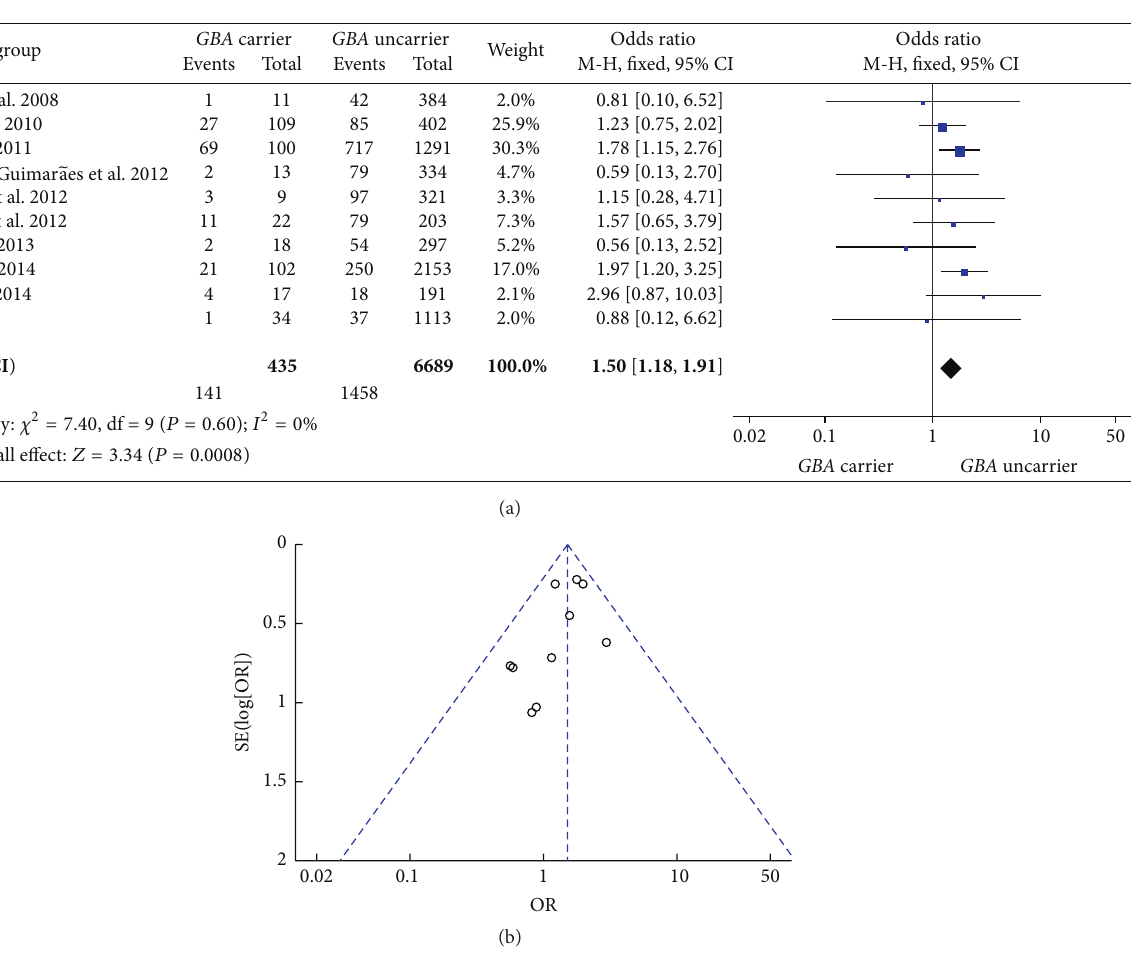
Figure 2: (a) Forest plot of family history in GBA + PD and GBA − PD. (b) Funnel plot of family history in GBA + PD and GBA −